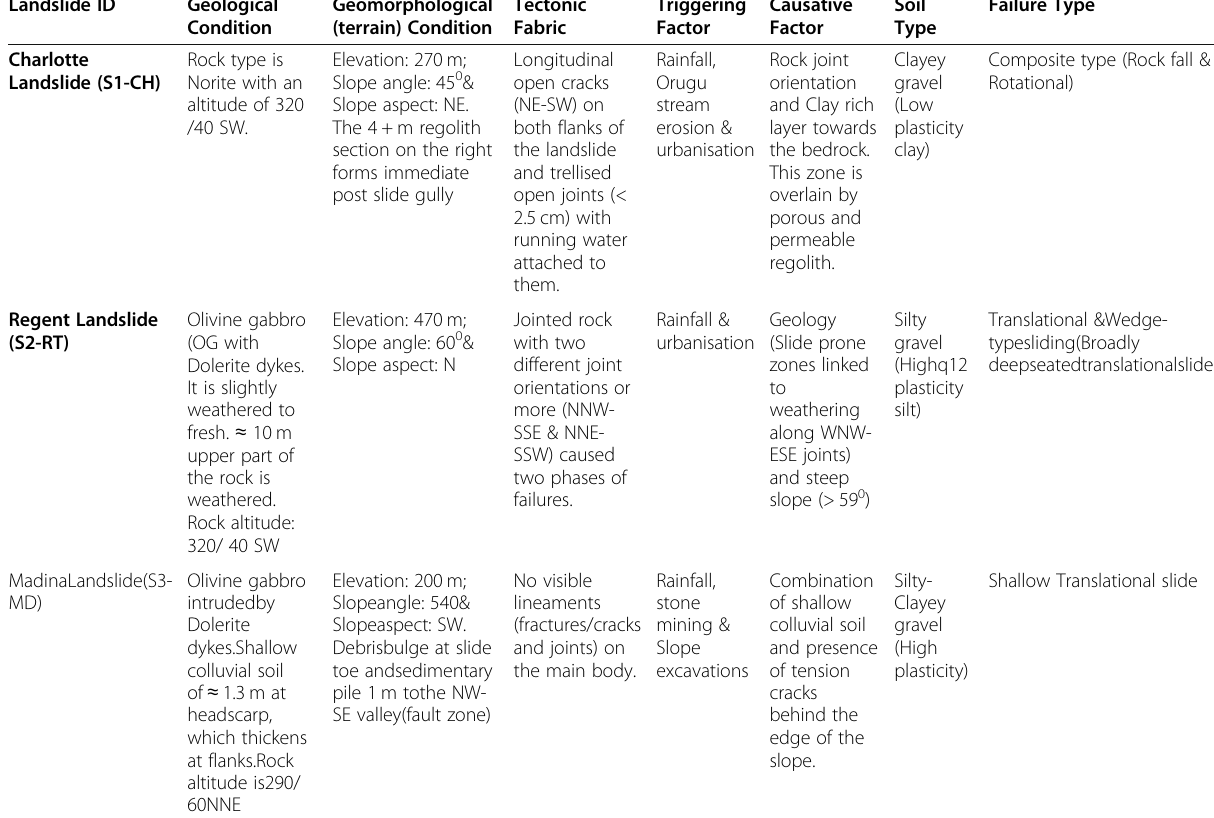
Table 3 Comparative GTG Characteristics of the Charlotte, Regent and Madina landslides Landslide ID Geological Geomorphological Tectonic Condition (terrain) Condition